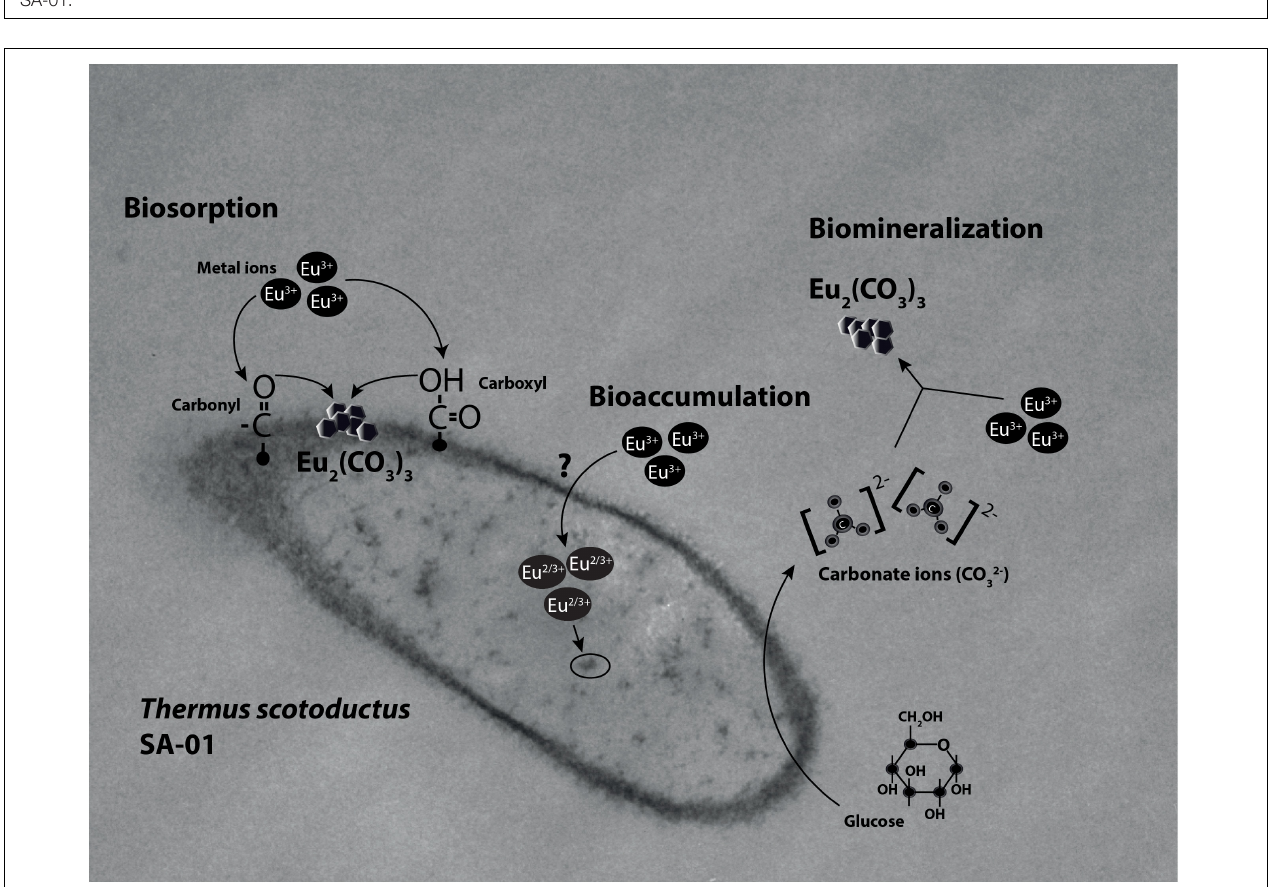
FIGURE 7 | Illustration of the interaction mechanisms of T . scotoductus SA-01 with Europium.